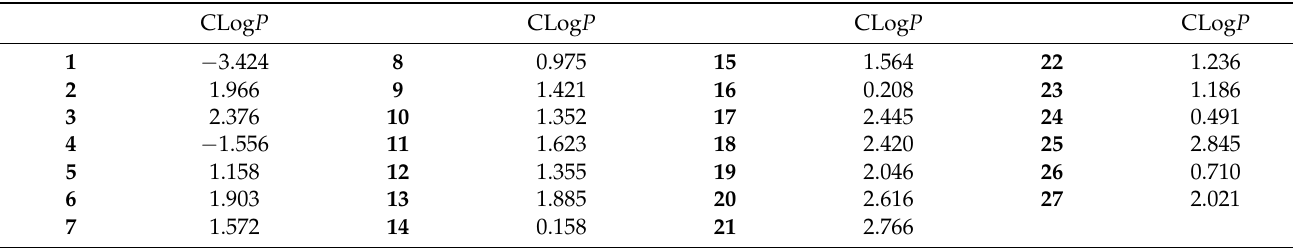
Figure 7. Increased trichome formation in Cuscuta root apices treated with hydrocinnamic acid ( 6 ) ( A ) in comparison with smother Cuscuta root apices treated with control ( B ). Calculated CLog P values of the tested compounds 1 – 27 . The calculated CLog P values are shown in Table 1. In general, all the values were in the range of 0 – 3, except in two cases, the amino acids 1 and 4 , for which negative values were calculated. Table 1. Calculated CLog P values for compounds 1 – 27 .